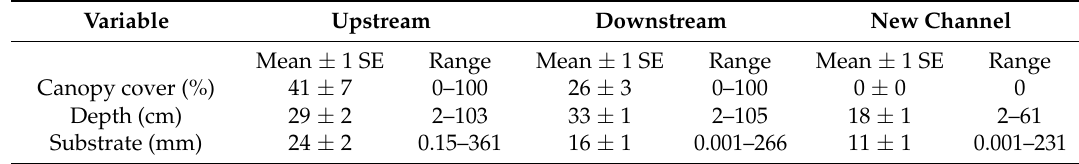
Table 1. Summary of habitat variables for the upstream control site, sites downstream of channel reconfiguration, and new channel sites. Data is pooled across years and channel